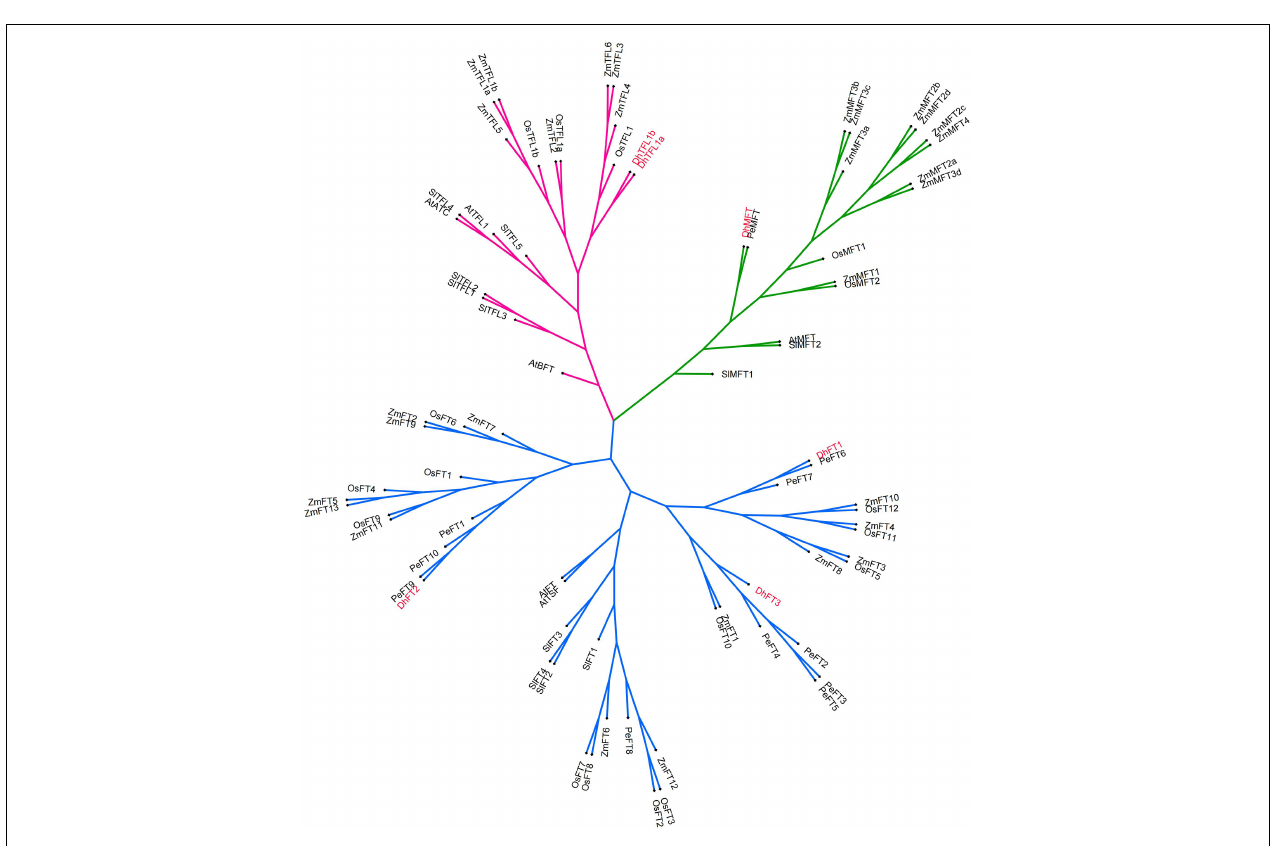
FIGURE 4 | The phylogenic tree of five species by ML